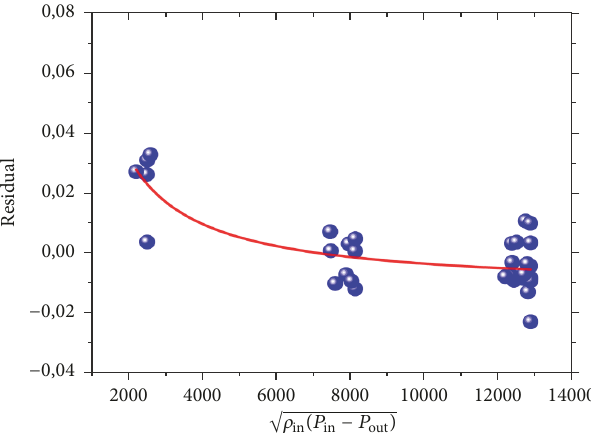
Figure 16: Curve fitting of the residual for the long teeth with the operating parameter.